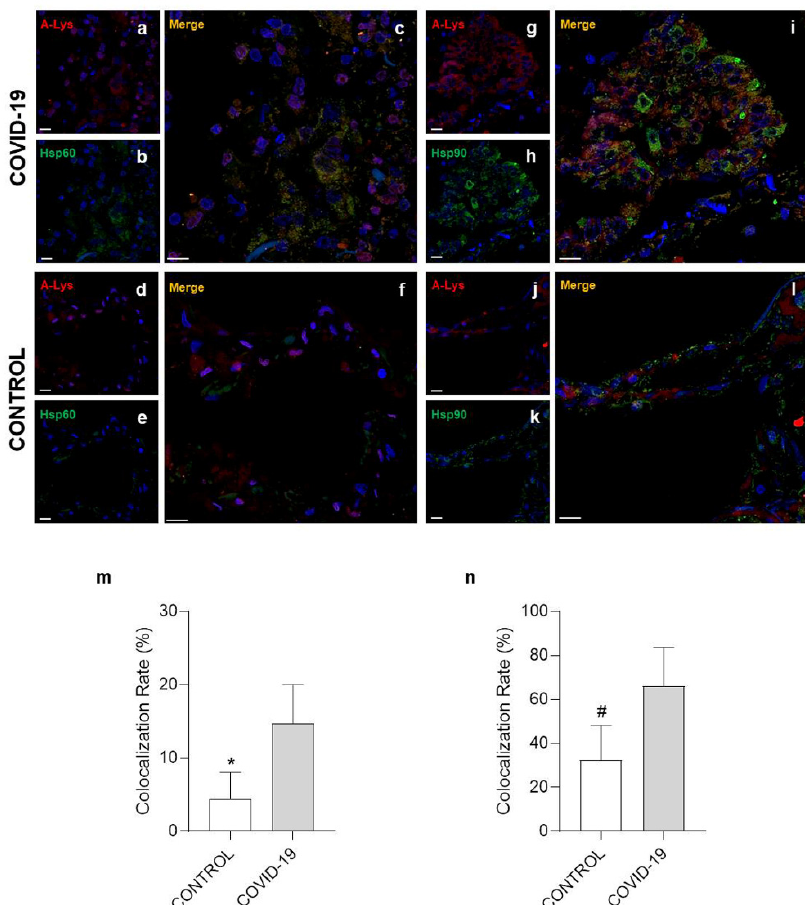
Figure 5. Immunofluorescence for acetylate-lisine, Hsp60, and Hsp90. ( a – c , g – i ) Representative images of COVID-19 lung parenchyma. ( a , b ) Representative immunofluorescence for acetylate-lisine (( a ), red) and Hsp60 (( b ), green); nuclei stained with DAPI are shown in blue. ( c ) The panel shows the merged confocal laser scanning image of acetylate-lisine, Hsp60, and nuclei. ( g , h ) Representative immunofluorescence for acetylate-lisine (( g ), red) and Hsp90 (( h ), green); nuclei stained with DAPI are shown in blue. ( i ) The panel shows the merged confocal laser scanning image of acetylate-lisine, Hsp90, and nuclei. ( d – f , j – l ) Representative images of control lung parenchyma. ( d , e ) Representative immunofluorescence for acetylate-lisine (( d ), red) and Hsp60 (( e ), green); nuclei stained with DAPI are shown in blue. ( f ) The panel shows the merged confocal laser scanning image of acetylate-lisine, Hsp60, and nuclei. ( j , k ) Representative immunofluorescence for acetylate-lisine (( j ), red) and Hsp90 (( k ), green); nuclei stained with DAPI are shown in blue. ( l ) The panel shows the merged confocal laser scanning image of acetylate-lisine, Hsp90, and nuclei. ( m , n ) The bar graph shows the colocalization ratio (%) for acetylate-lisine /Hsp60 ( m ) and acetylate-lisine /Hsp90 ( n ). Open bar, control; shaded bar, COVID-19. Data are presented as the means ± SD. * significantly different from COVID-19 group ( p = 0.0185). # significantly different from COVID-19 group ( p = 0.0282). Scale bar 25 µm.